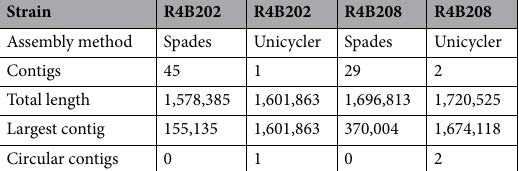
Table 7. Field Isolate Assembly Summary. Genomes were assembled using SPAdes or Unicycler.